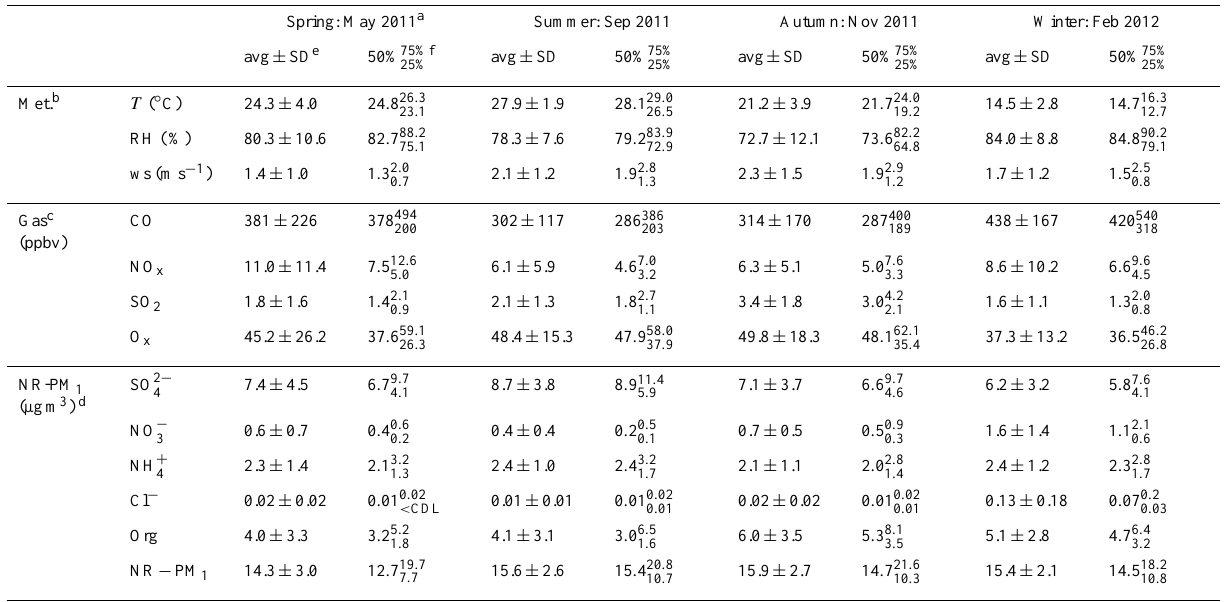
Table 2. Monthly meteorological conditions, mixing ratios of gaseous species, and mass concentrations of NR-PM 1 species in the four measurement